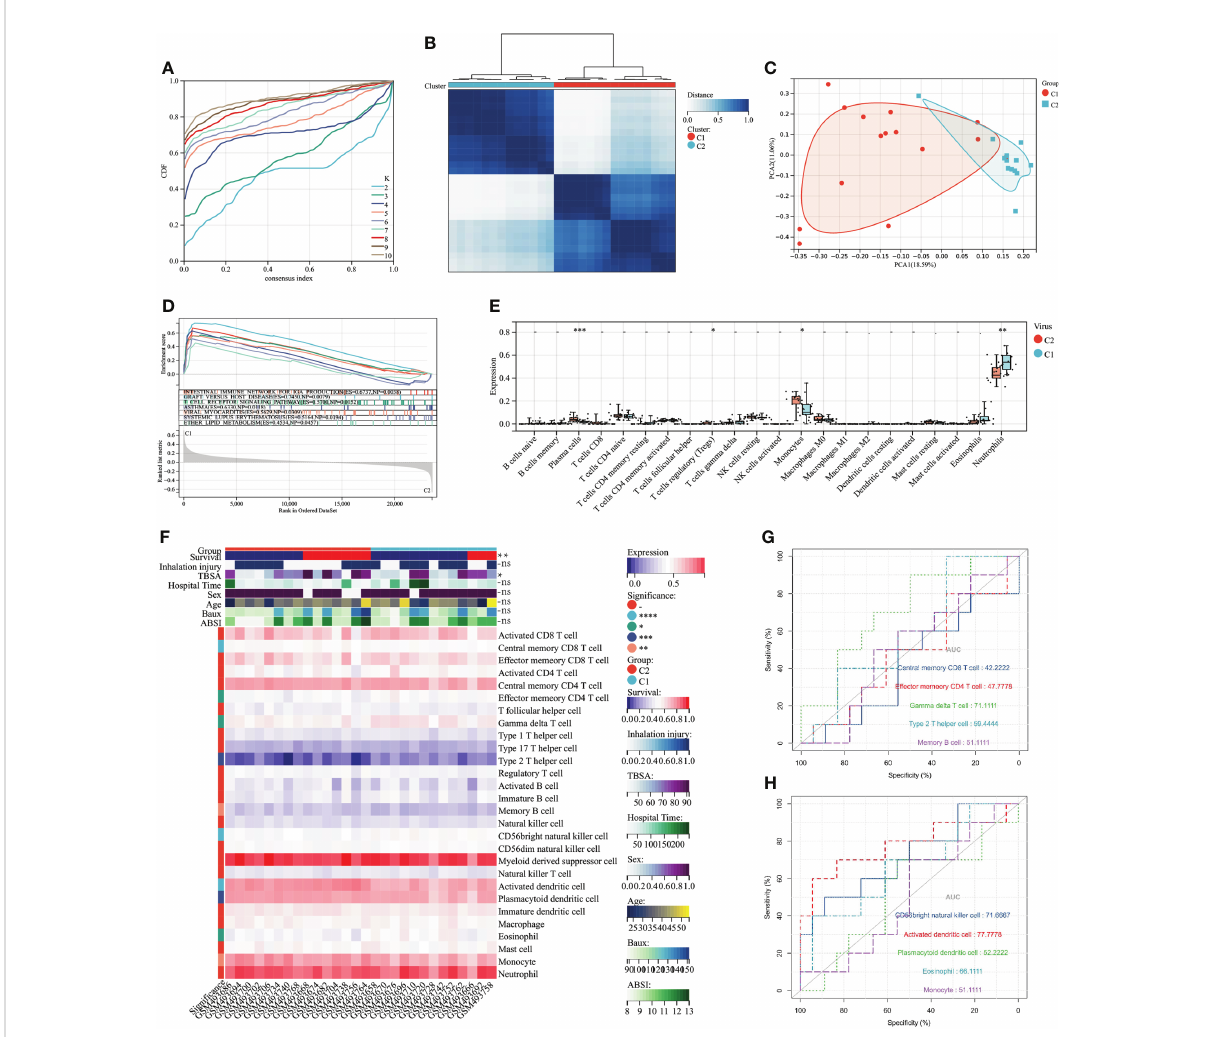
FIGURE 3 Consensus clustering and its grouping for clinical properties and immunological analysis. (A) Different colored lines represent different K (number of sample groups). According to the evaluation of the area under the CDF curve, the area under the CDF curve gradually increases when the K value increases. Here, the clusters with the highest average consistency in the group are the number of clusters is K=2, and the number of the next highest cluster is K=4. (B) When K=2, the samples can be divided into 2 groups with different expression patterns (C1 and C2). (C) The dots of different colors represent different groups. PCA is performed according to the gene expression data. The gene expression pro fi les of the two groups of patients in the fi gure are signi fi cantly different. (D) The results of GSEA showed that different colors represent enriched pathways; ES > 0 indicates that the genes of C1 are enriched in this pathway, and ES < 0 means that the genes of C2 are enriched in this pathway. (E) Comparison of 22 immune cells between C1 and C2 subgroups. The vertical axis represents the proportion of immune cells. Cells with P < 0.05 were considered to be different between groups. (F) ssGSEA results. In the C1 and C2 subgroups, showing differences in clinical shape, immune cells, and immune function, P < 0.05 was considered to be different between the different subgroups. (G) Immune cells and immune function ROC curves with signi fi cant differences. The larger the AUC value, the better the predictor of the patient ’ s prognosis. P < 0.05:*, P < 0.01:**, P < 0.001:***P < 0.0001:****, P >